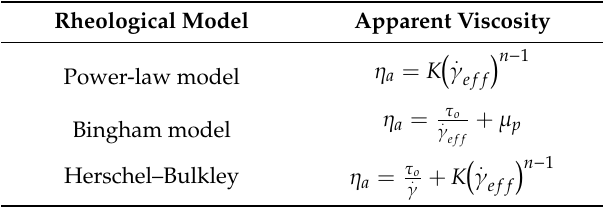
Table 1. Investigated rheological models and apparent